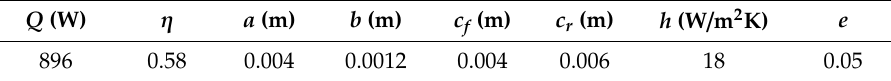
Table 1. Parameters for the heat input and heat